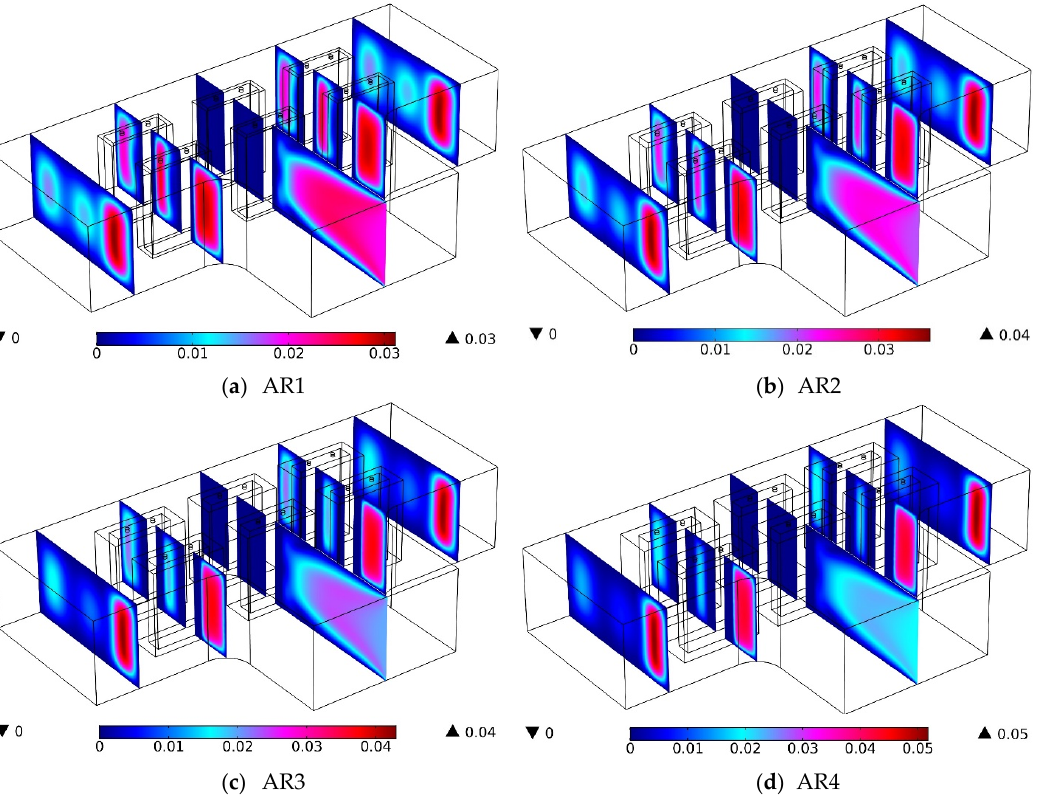
Figure 6. Air velocity contours (in m/s) on cross-sections of the BTPC for different values of cavity AR.